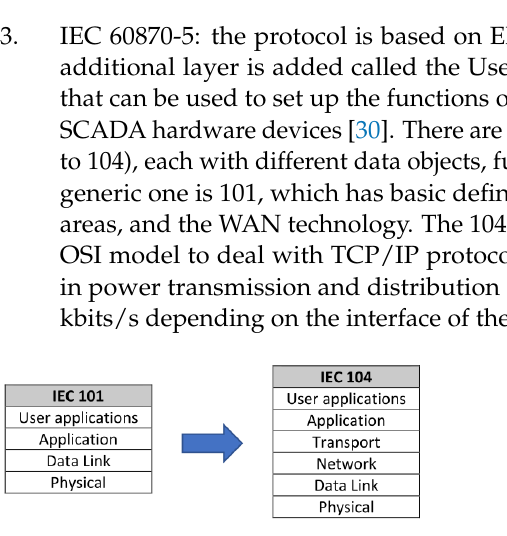
Figure 3. OSI, EPA and DNP3 Models.